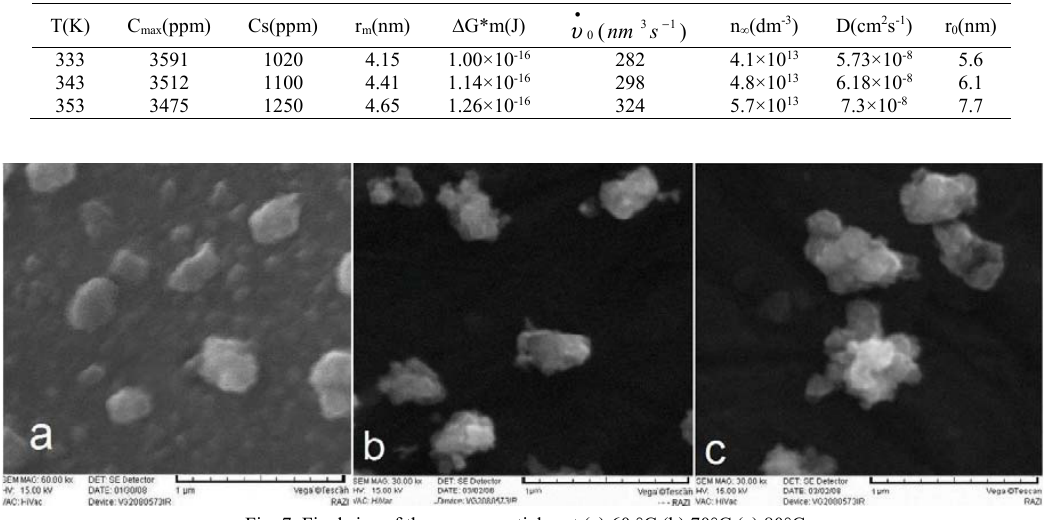
Fig. 7. Final size of the grown particles at (a) 60 °C (b) 70°C (c) 80°C